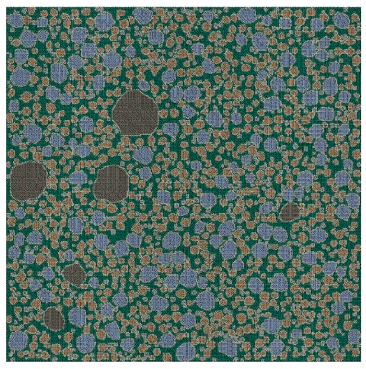
Figure 7. 2D RPA model after meshing.